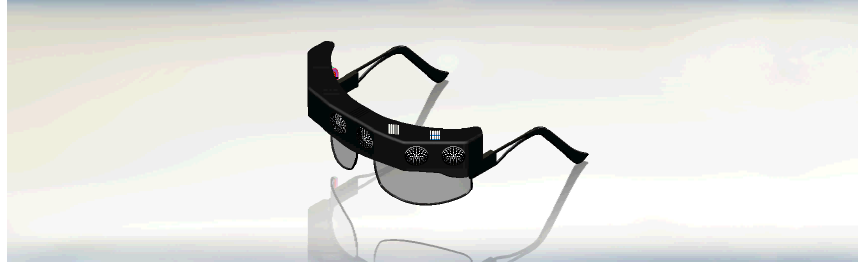
Figure 3. The designed frame with its integrated